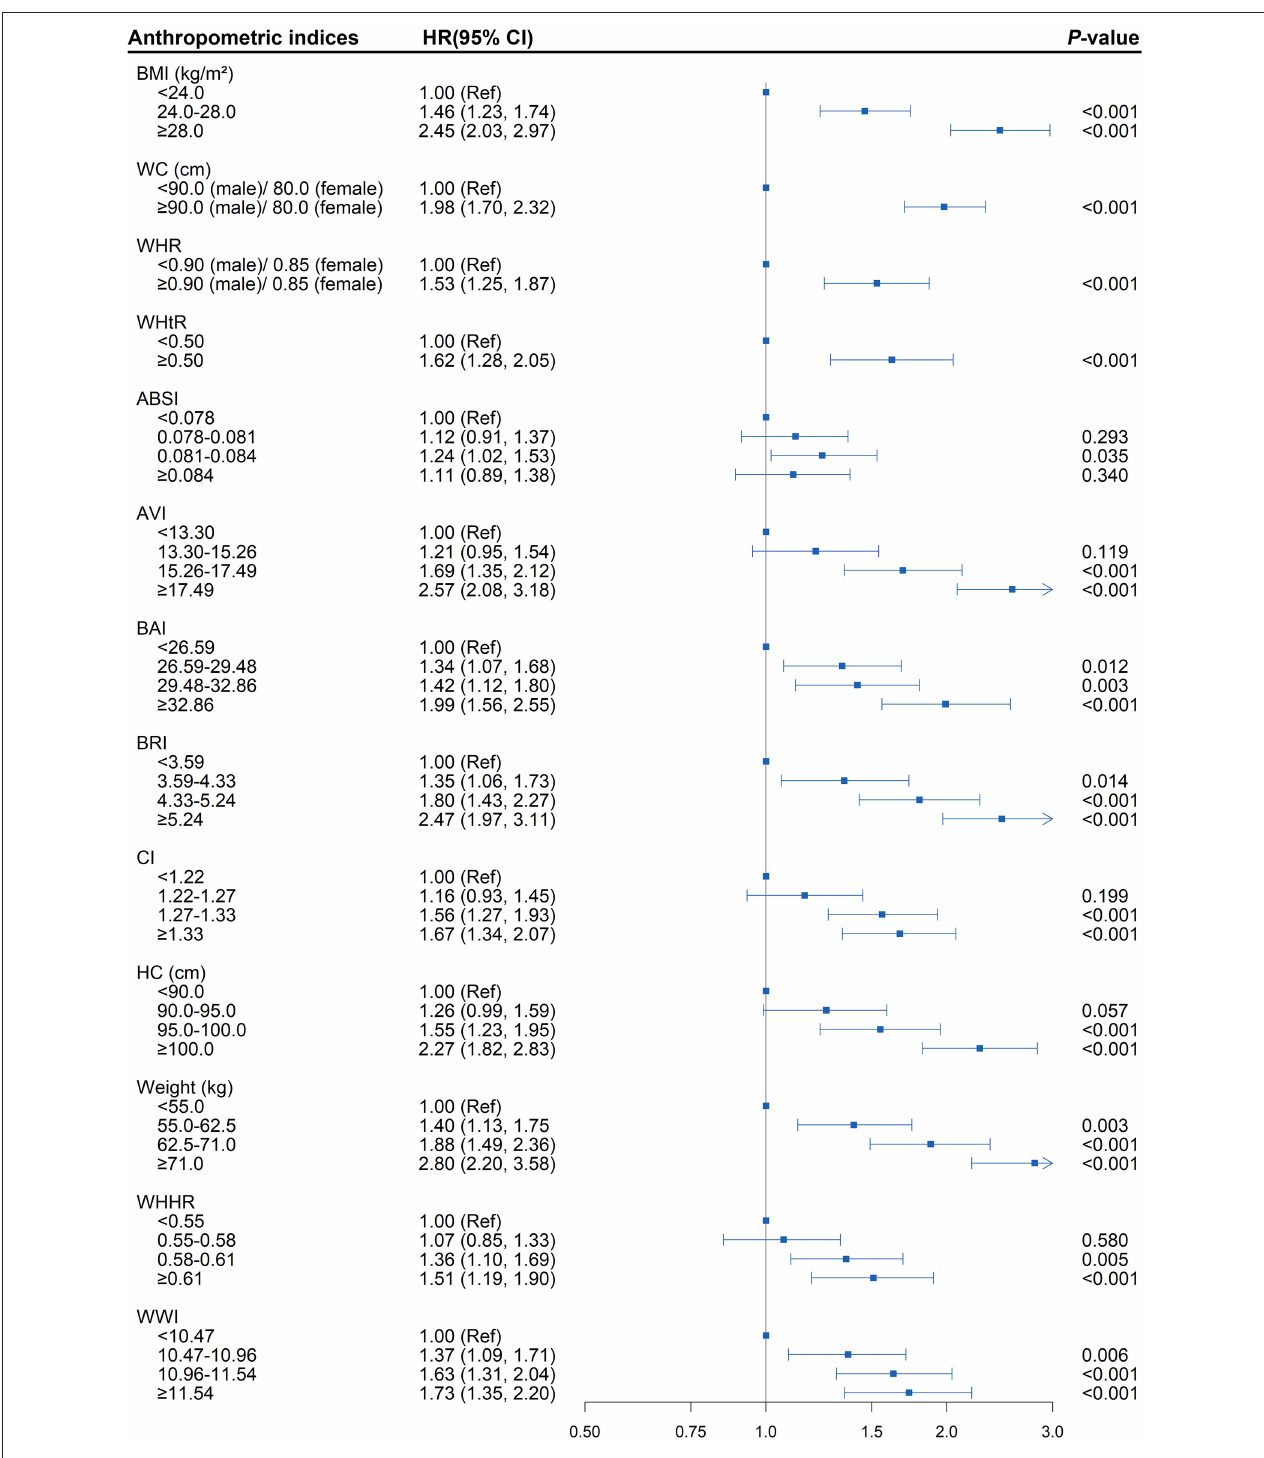
FIGURE 2 | Association between separate anthropometric indices with diabetes (body mass index [BMI], waist circumference [WC], waist-to-hip ratio [WHR], waist-to-height ratio [WHtR], a body shape index [ABSI], abdominal volume index [AVI], body adiposity index [BAI], body roundness index [BRI], conicity index [CI], hip circumference [HC], weight, waist-hip-height ratio [WHHR], weight-adjusted-waist index [WWI]). The correlation was assessed by multivariate cox regression analysis, adjusted by sex, age, smoking status, drinking status, fasting plasma glucose, serum triglycerides, total cholesterol, high-density lipoprotein, low-density lipoprotein, systolic blood pressure, and diastolic blood pressure at baseline. Hazard ratios (HRs) of the anthropometric indices were represented as the squares and 95% confidence intervals (CIs) by the lines through the squares.